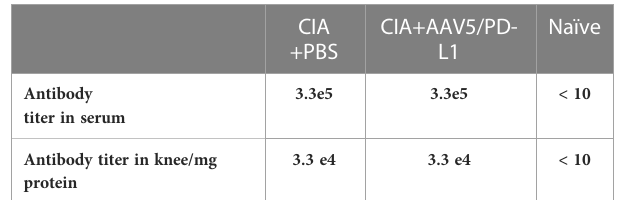
TABLE 1 Antibody titer against type II collagen in mouse serum and